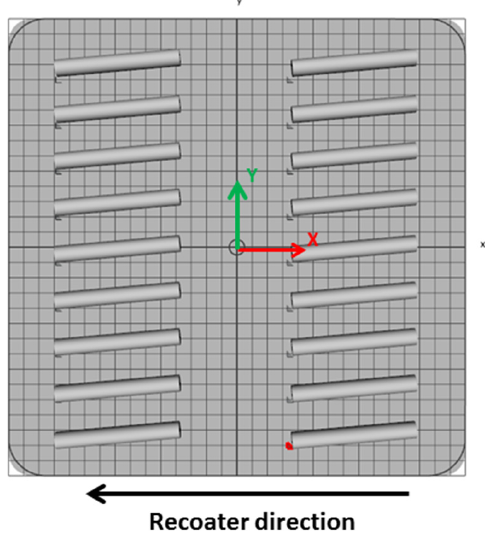
Figure 1. Positioning of the rods on the building plate.